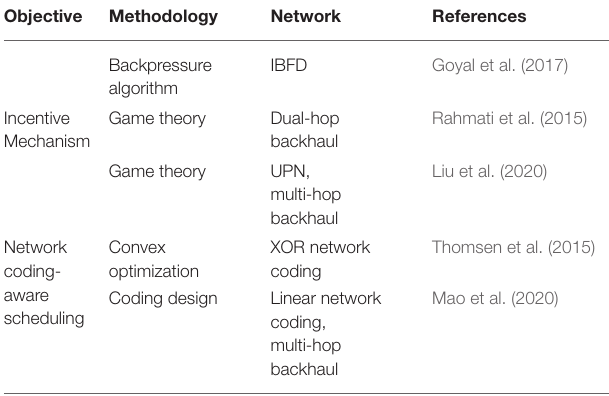
TABLE 3 | Taxonomy of literature in section